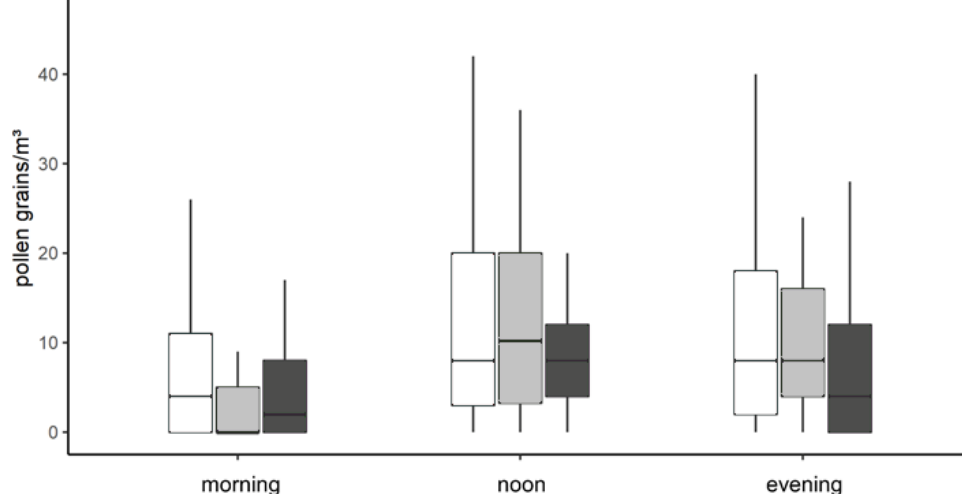
Figure 8. Boxplots showing distribution of pollen concentrations by measurement period. Horizontal line = median, boxes = interquartile range. Outliers not shown. Colours for sampling locations: white—city centre, light grey—residential area, dark grey—semi-rural area.